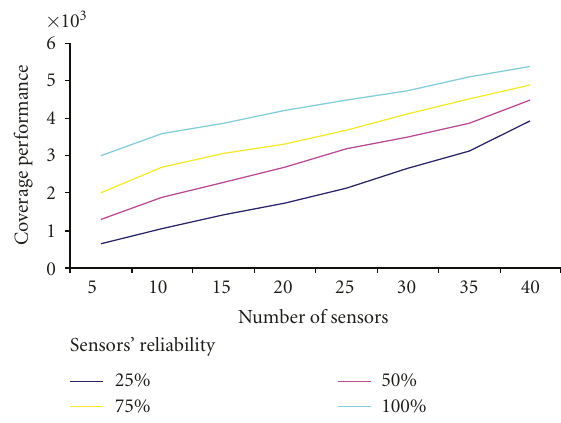
Figure 15: E ff ect of sensors’ state-switching on the coverage per- formance of GA and SA.